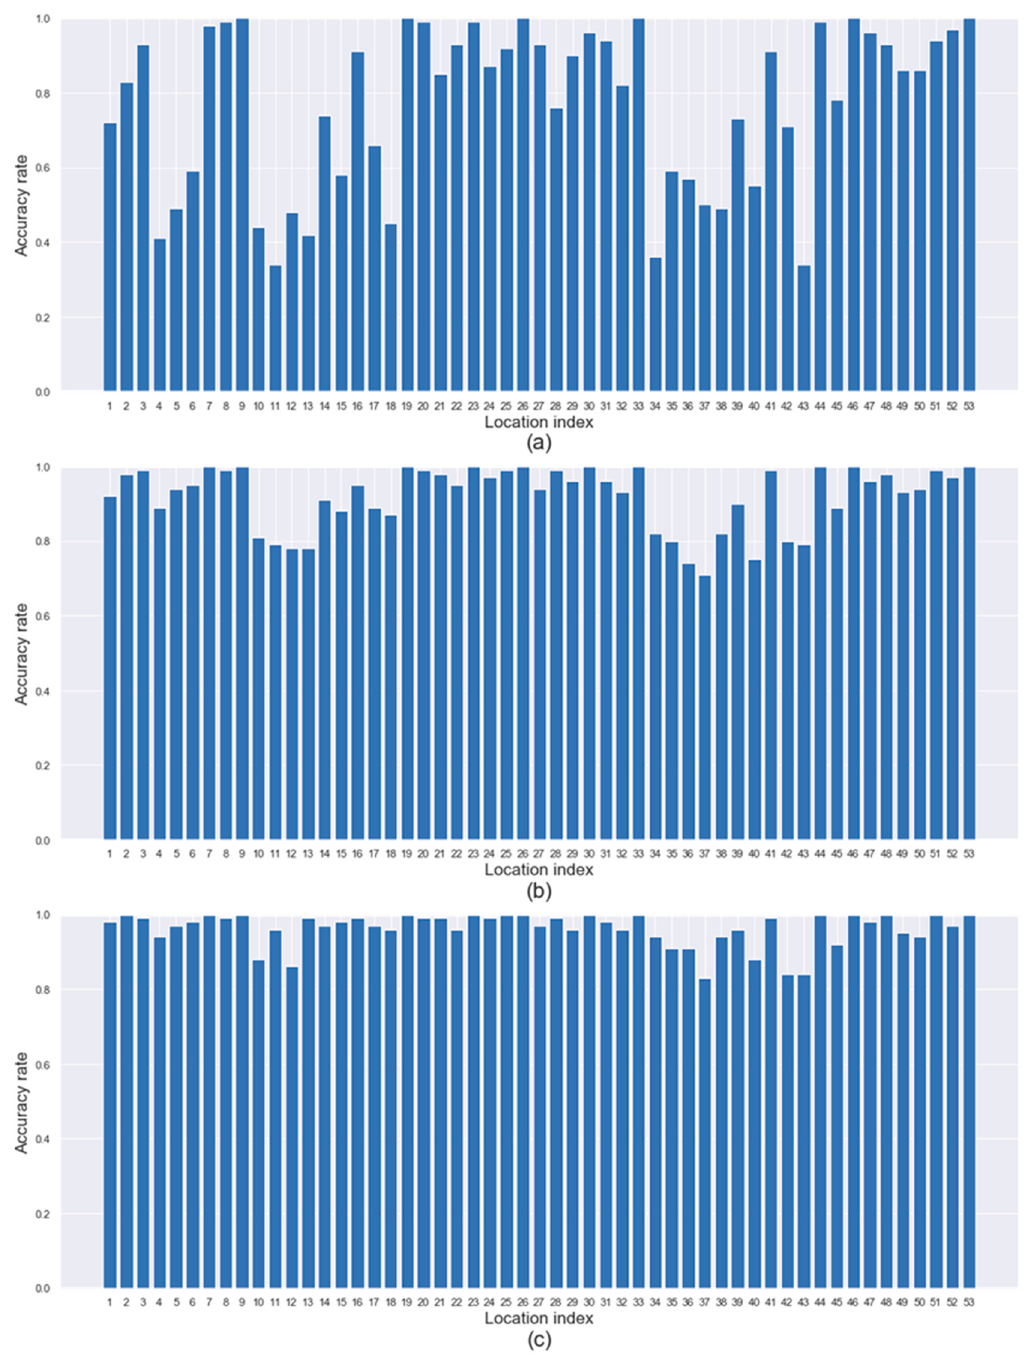
Figure 8. Identification accuracy regarding the top three locations under (H, H) configuration.